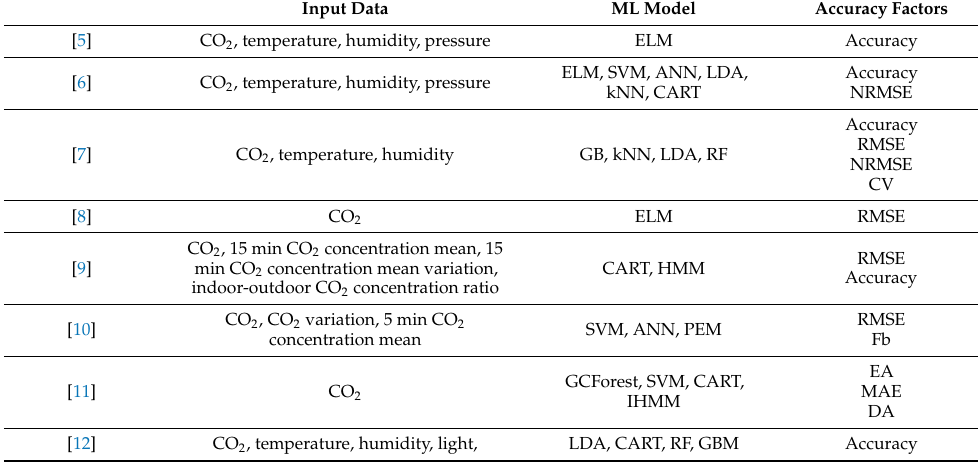
Table 1. Previous research on the CO 2 concentration based on the occupancy